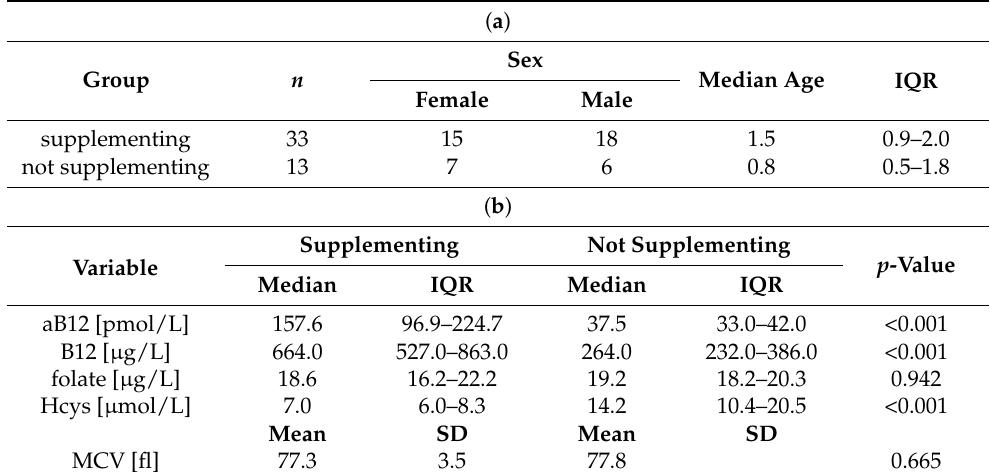
Table 11. ( a ) Basic description of subgroup analysis VG/VN breastfed children aged 0–3